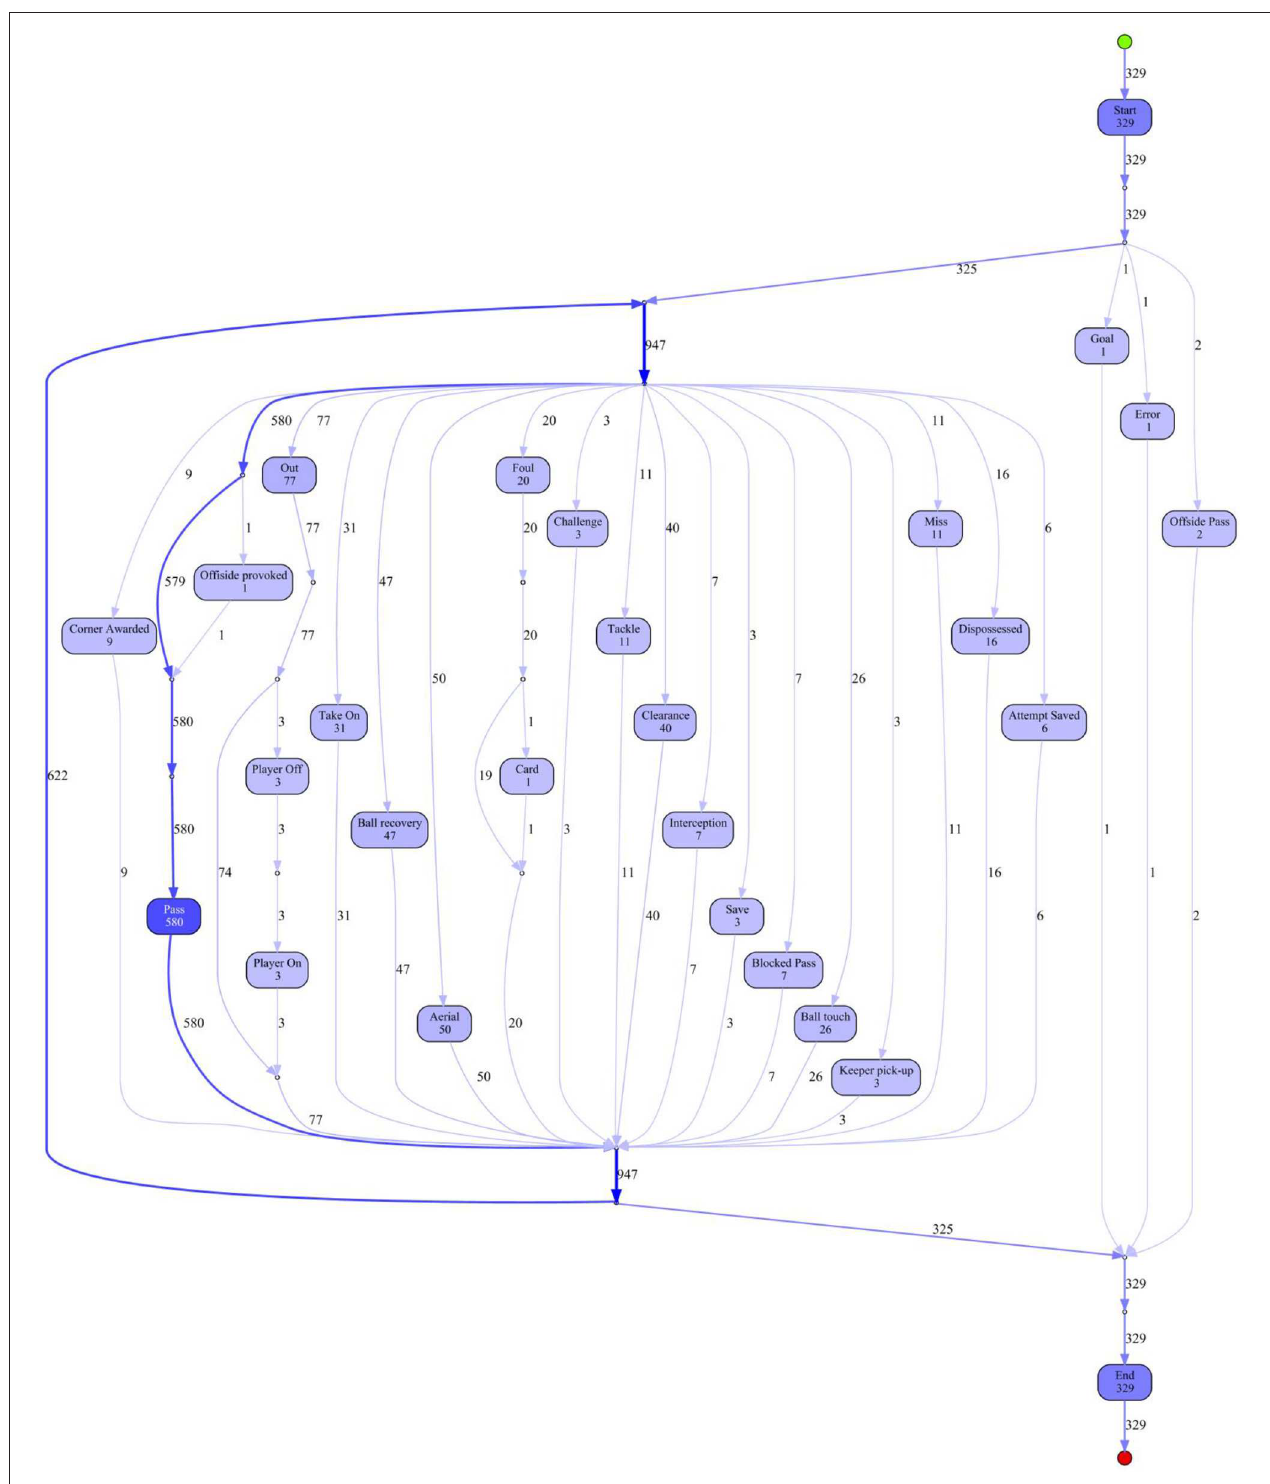
FIGURE 1 | Process model of England’s team by using the Inductive Visual Miner. of actions that characterize both the team and its players. As discussed, there are various algorithms that can be used to derive a process model from event log data. The algorithms are initially